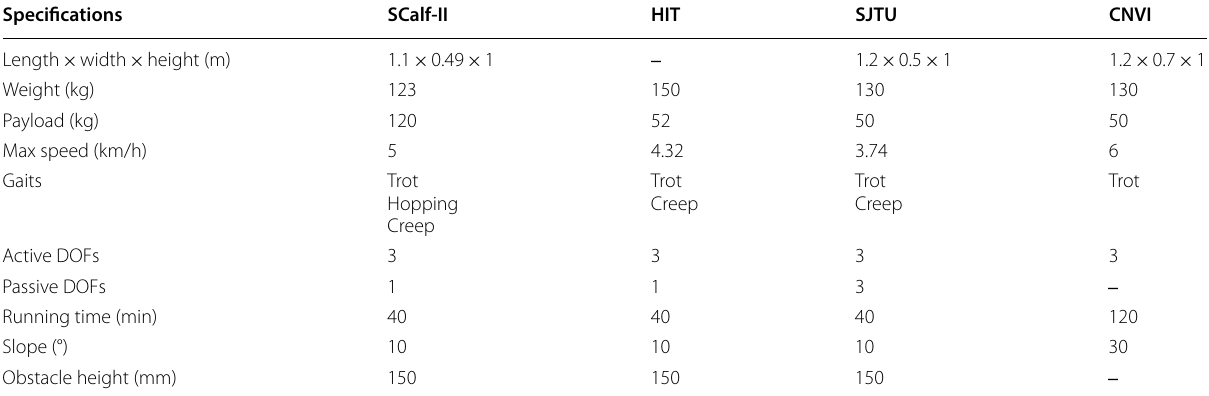
Table 2 Specifications of SCalf-II, HIT, SJTU, and CNVI quadruped robots [26–28]